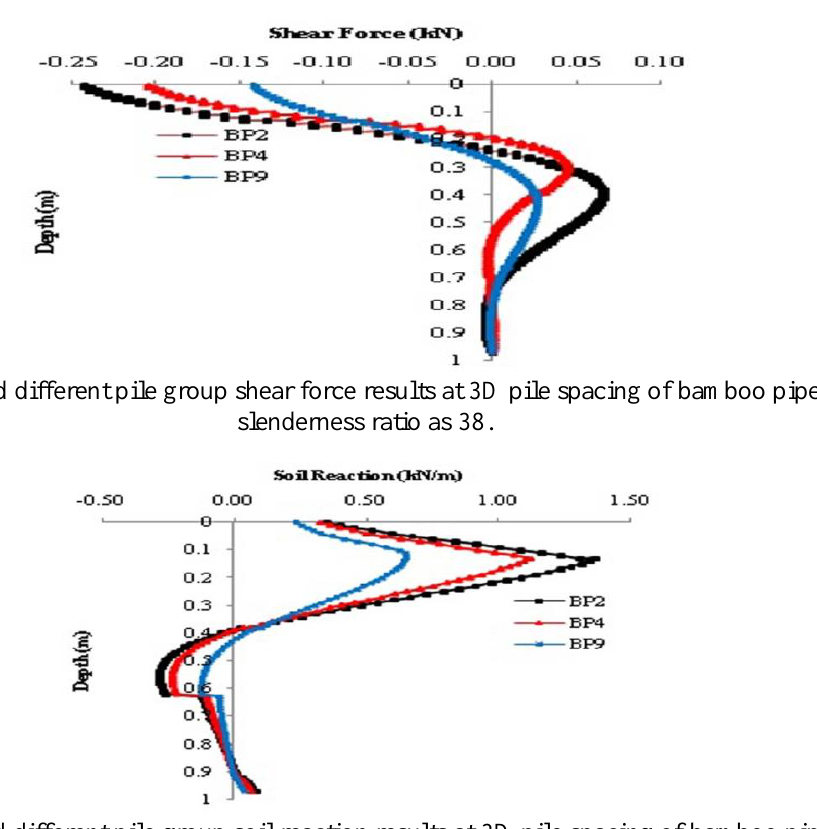
Fig. 20. Predicted different pile group soil reaction results at 3D pile spacing of bamboo pipe piles in loose layer in-between dense layers for slenderness ratio as